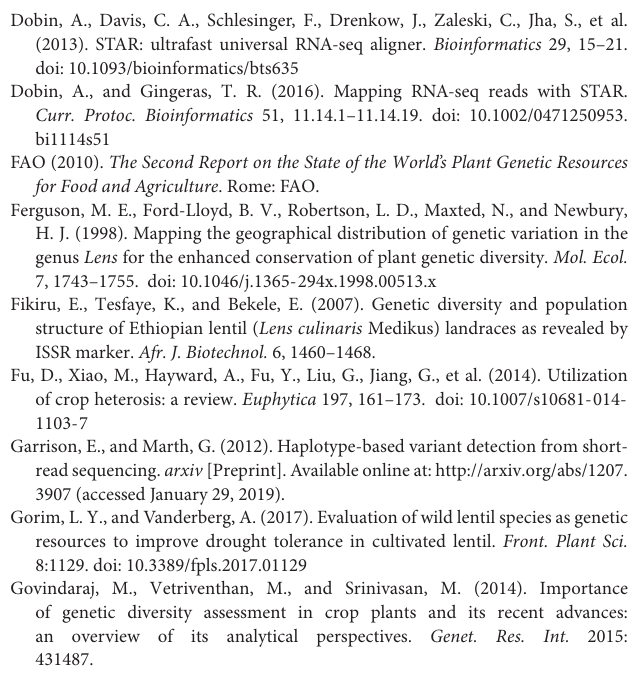
FIGURE S1 | Unweighted neighbor joining dendrogram generated from all Lens species based on genetic distance calculation from StAMPP in R. Of the L. culinaris set, only a proportion of key accessions is included. FIGURE S2 | Genetic relationships between lentil genotypes with respect to their geographical origin. (A) L. culinaris (B) L. orientalis (C) L. odemensis (D) L. ervoides (E) L. nigricans . FIGURE S3 | Graphical representation of fastSTRUCTURE results ( K = 5). FIGURE S4 | Allelic polymorphism detected in other chromosome regions. (A) Region 2 on LcChr2 (B) Region 3 on LcChr4 (C) Region 4 on LcChr4 (D) Region 5 and 6 on LcChr7. TABLE S1 | List of c. 4 million high-confidence SNPs used in genetic diversity analysis. TABLE S2 | Information of lentil accessions used in this study and their geographical origins. TABLE S3 | Lentil accessions with wide genetic distances, which are found within L . culinaris , L . ervoides , and L . nigricans. TABLE S4 | List of c. 5 million high-confidence SNPs used in allele frequency–based analysis. TABLE S5 | Data sets used in allele frequency-based